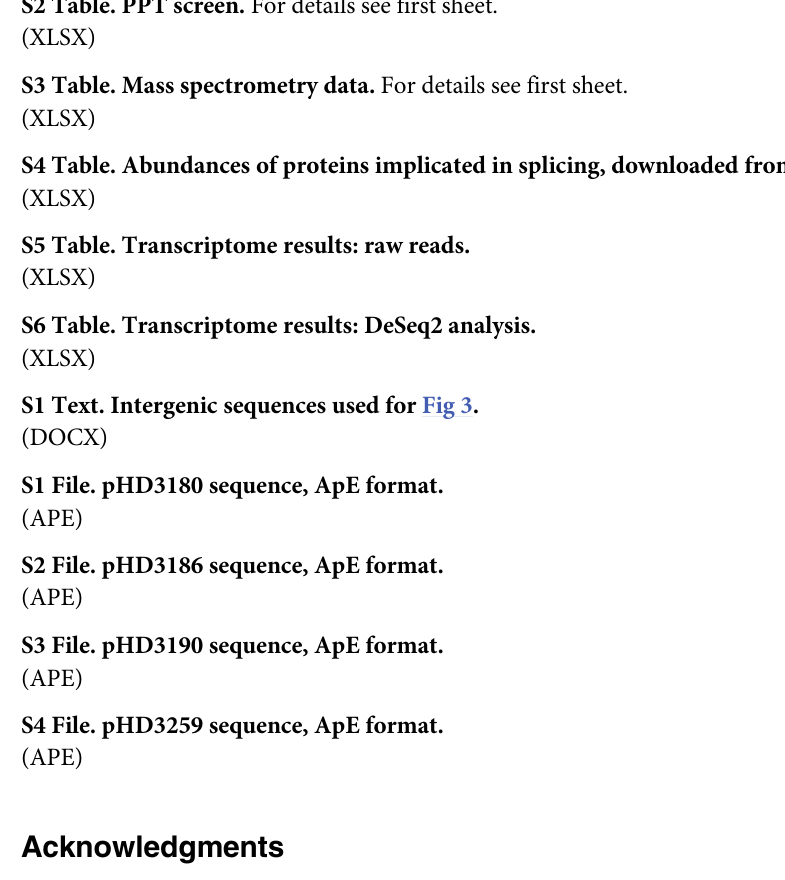
S1 Table. Plasmids and oligonucleotides. S2 Table. PPT screen. For details see first sheet. S3 Table. Mass spectrometry data. For details see first sheet. S4 Table. Abundances of proteins implicated in splicing, downloaded from [70]. S5 Table. Transcriptome results: raw reads. S6 Table. Transcriptome results: DeSeq2 analysis. (XLSX) S1 Text. Intergenic sequences used for Fig